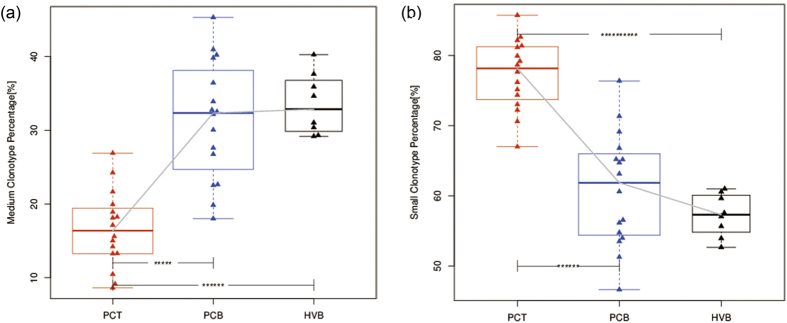
Differences in different clonotypes in the three groups.T cell clonotypes were categorized by different frequencies. (a) Tumor tissue samples showed significantly lower levels of medium frequency (0.001%–0.01%) clonotype compared to blood samples from the patients and healthy controls. (b) Tumor tissue samples showed significantly lower levels of medium frequency (<0.001%) clonotype compared to blood samples from the patients and healthy controls. ****P < 0.0001, *****P < 10−5, **********P < 10−10.